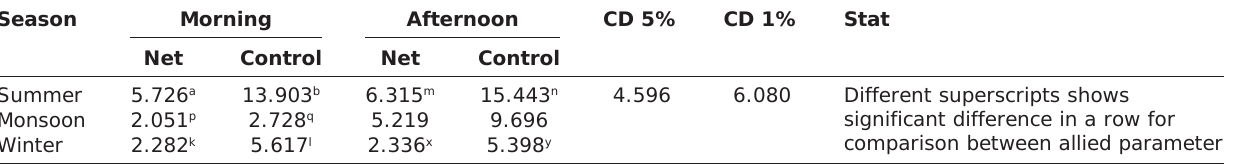
Table-5: Comparison of air changes estimated in the net shed and control shed. Season